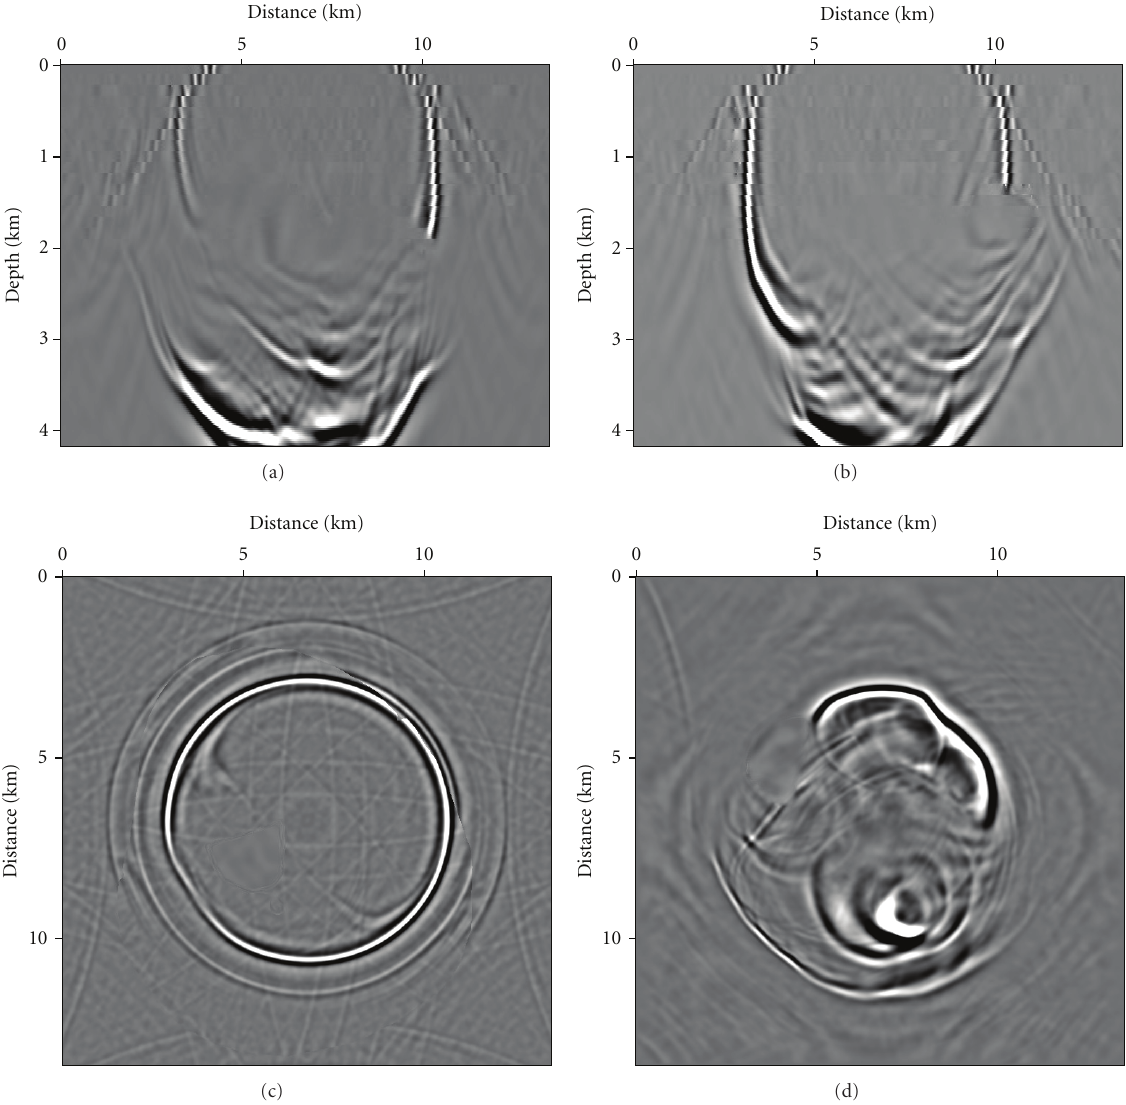
Figure 10: Impulse response obtained by FD migration with rotation angle of 45 ◦ , 3 terms, mean slowness, and Li correction (cross-sections as